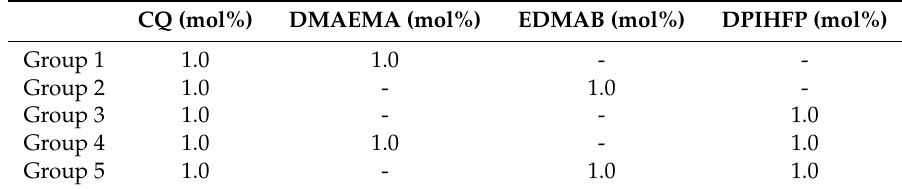
Table 1. Photoinitiator systems used in each experimental